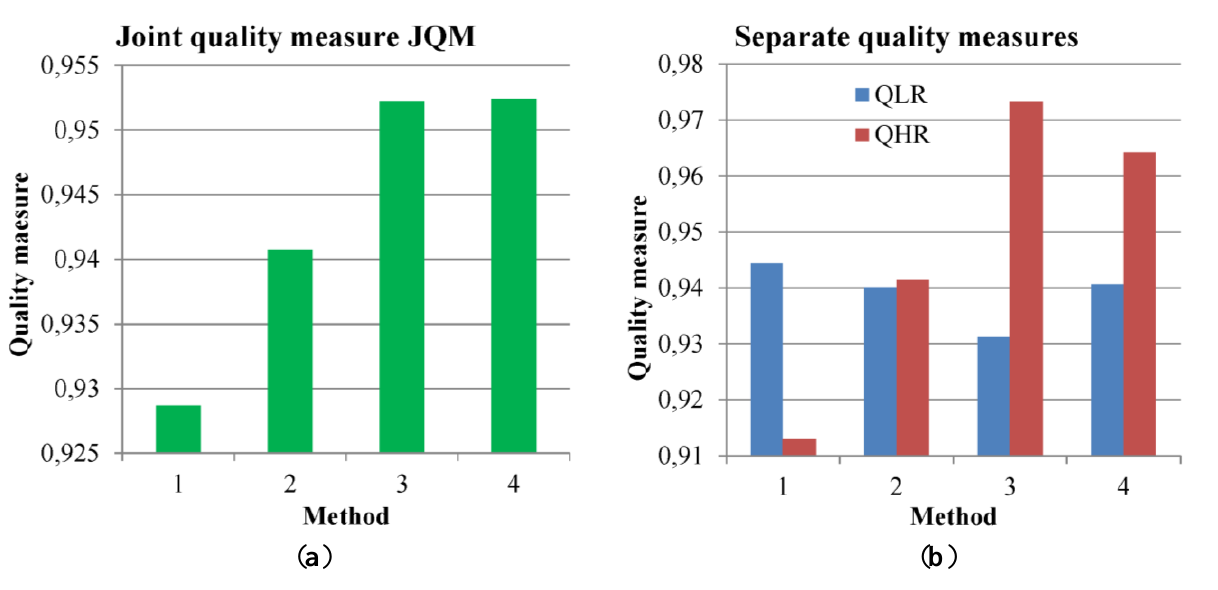
Figure 7. JQM quality assessment of High Pass Filtering Method (HPFM) for different interpolation methods: 1—NN, 2—ZP, 3—BIL, and 4—CUB for IKONOS data. ( a ) JQM, ( b ) QLR and